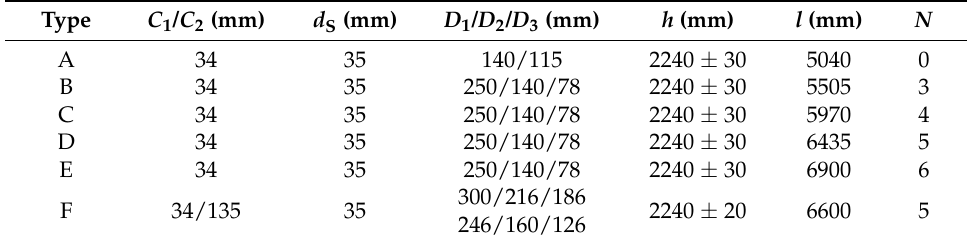
Table 1. Parameters of tested composite insulators.